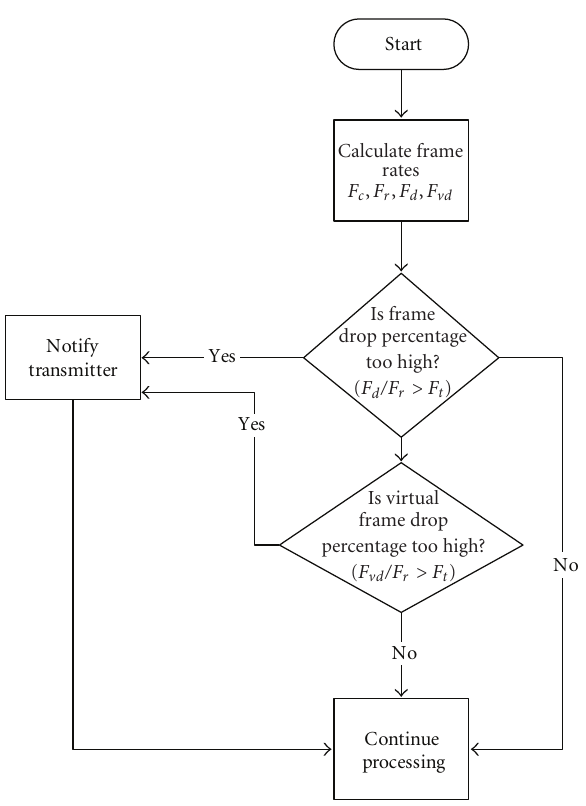
Figure 5: The adaptive frame rate algorithm (receiving machine).